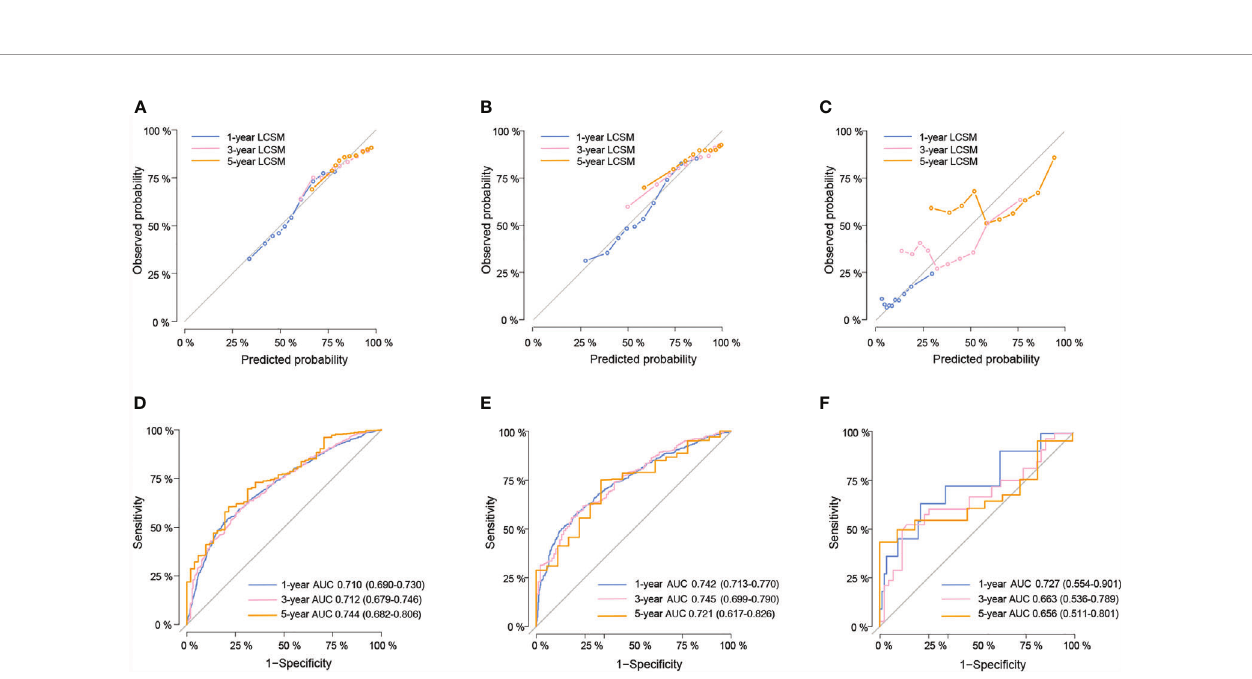
FIGURE 2 | The calibration curves for predicting lung cancer-speci fi c survival (LCSS) in the training (A) , internal validation (B) and external validation cohort (C) respectively. Nomogram-predicted probability is plotted on the x-axis; actual probability is plotted on the y-axis. A curve along the 45-degree line indicates perfect calibration models. Time-dependent ROC curves for the 1-, 3-, and 5-year LCSS probability in the training (D) , internal validation (E) and external validation cohorts (F) respectively.